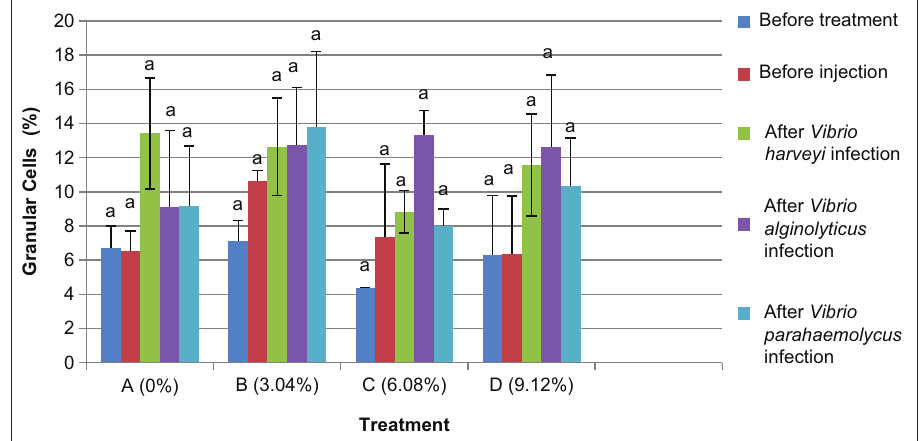
Figure-3: The number of granular cells of vannamei shrimp ( Litopenaeus vannamei ) before and after infected with Vibrio harveyi, Vibrio alginolyticus, and Vibrio parahaemolyticus and treatment with Majapahit ( Crescentia cujete L.) fruit powder. Data were indicated as mean value±SD. Graphs with different notations showed significantly different (p<0.05).